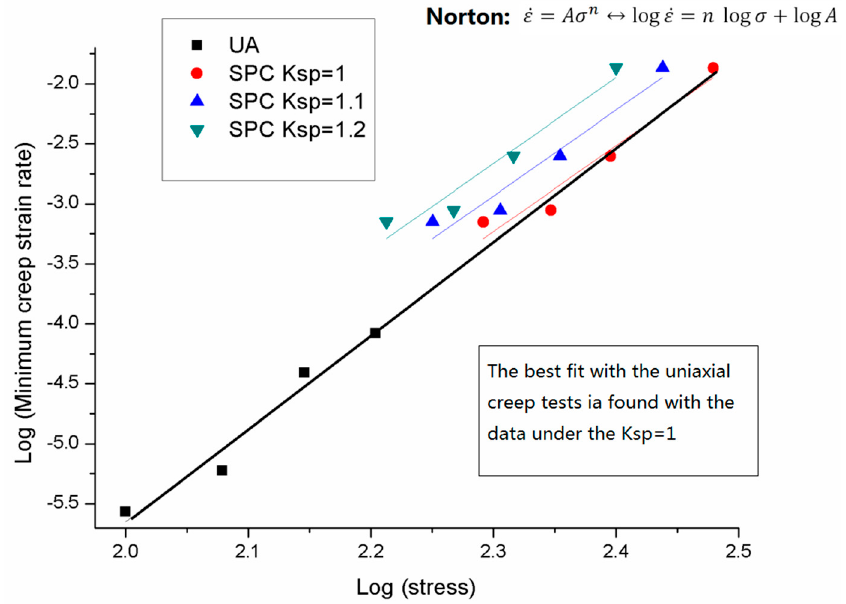
Figure 8. The Norton fitting results of the uniaxial creep results and the small punch results of 1.25Cr0.5MoSi.